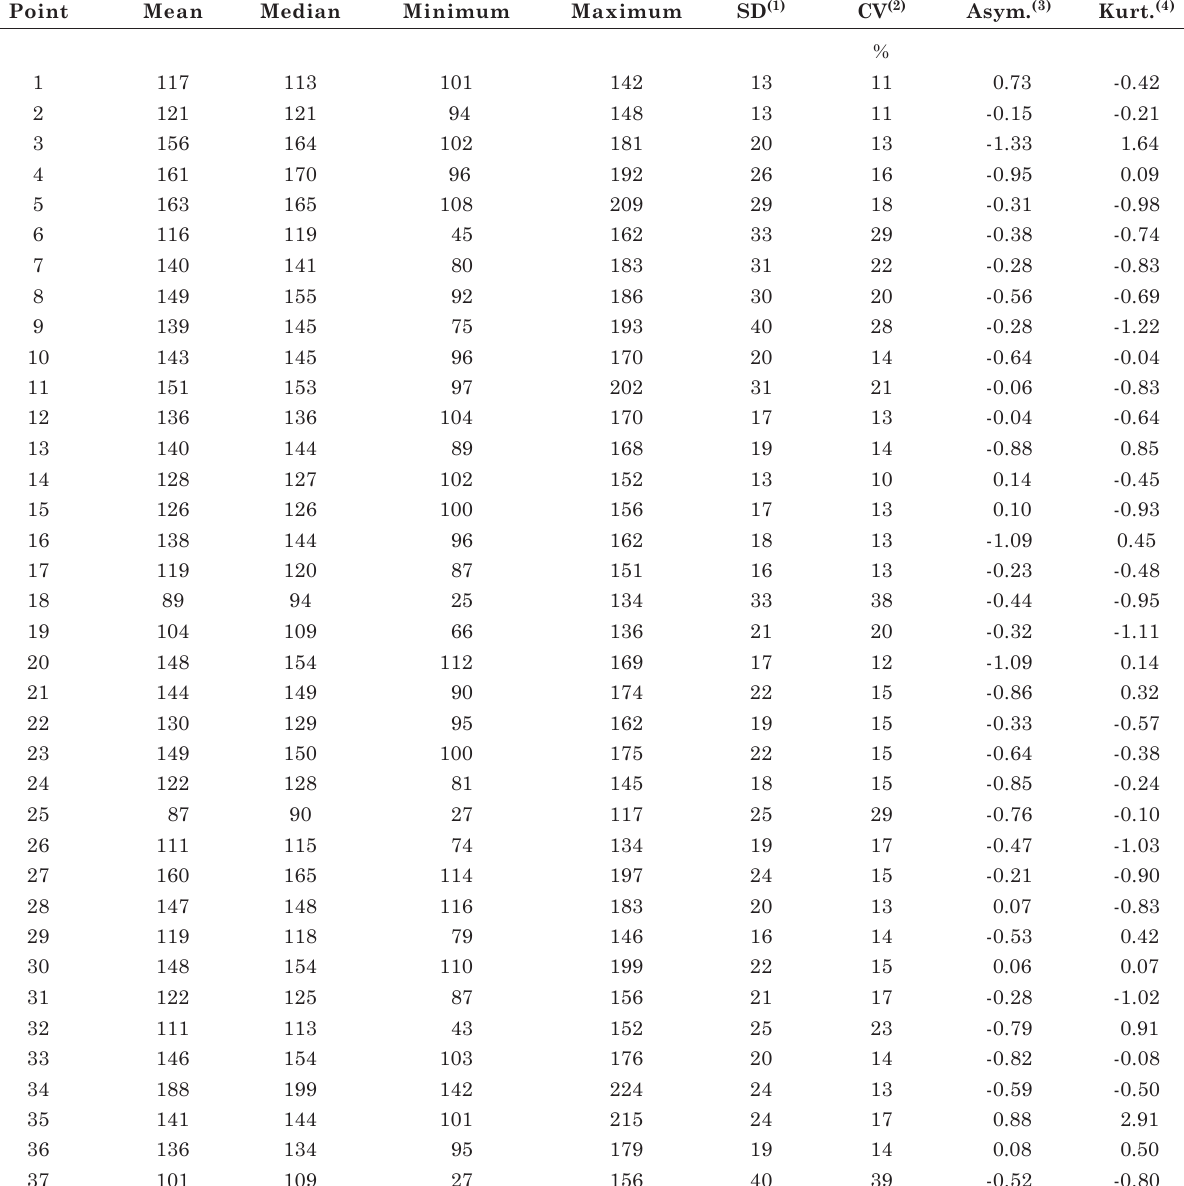
Table 1. Descriptive statistics of water storage (mm) in the 0.00-0.30 m layer of a Cambisol at each collection point for the sampling period (2008/2009 to 2009/2010); n=37 sampling